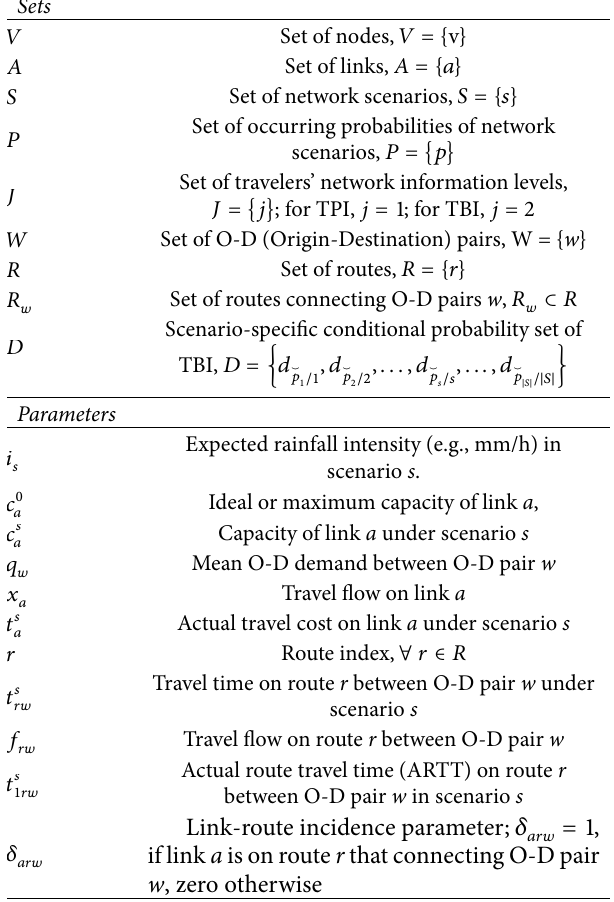
Table 1: The notion